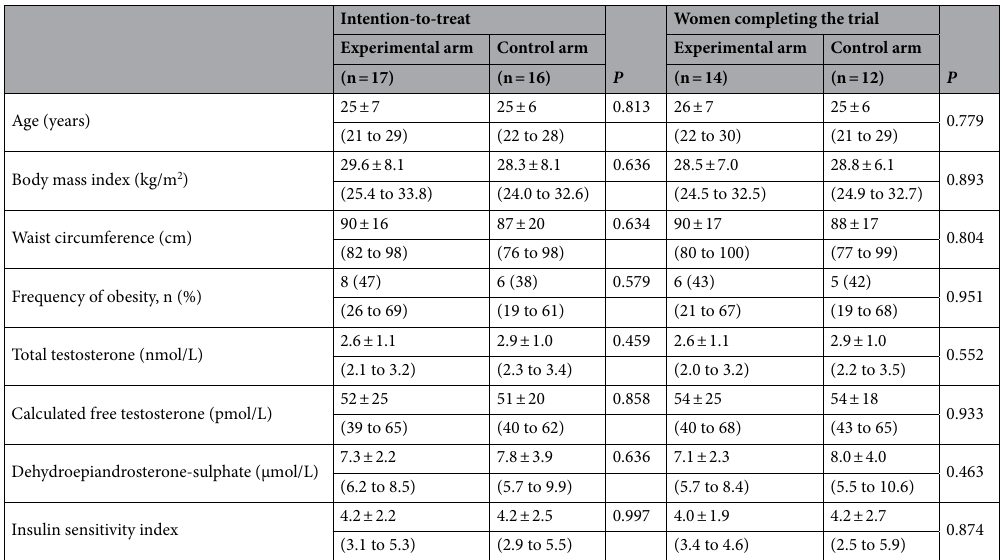
Table 1. Baseline characteristics of the hyperandrogenic patients in the experimental and control arms of the trial, both by intention-to-treat analysis and restricted to those patients who completed the trial. Continuous and discrete variables are shown as mean ± SD and counts (%), respectively. Figures below those statistics denote 95% confidence intervals (lower limit to upper limit). Continuous and dichotomous variables were compared by t and χ 2 tests, respectively.